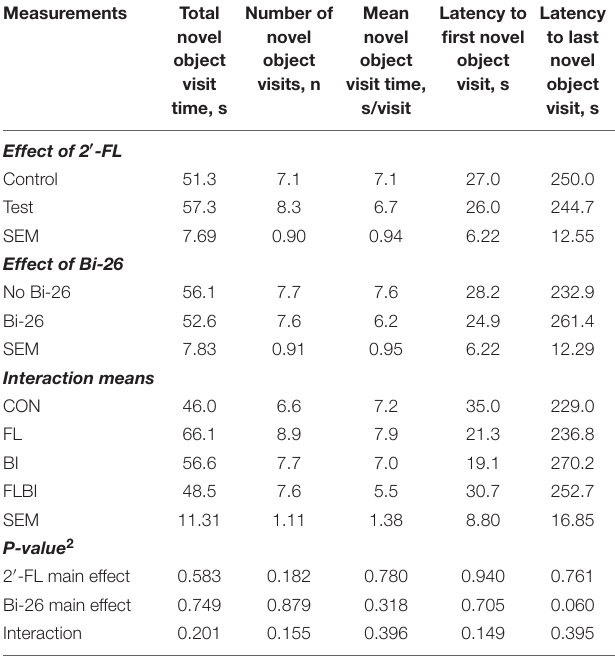
NOR task 1 . Measurements Total